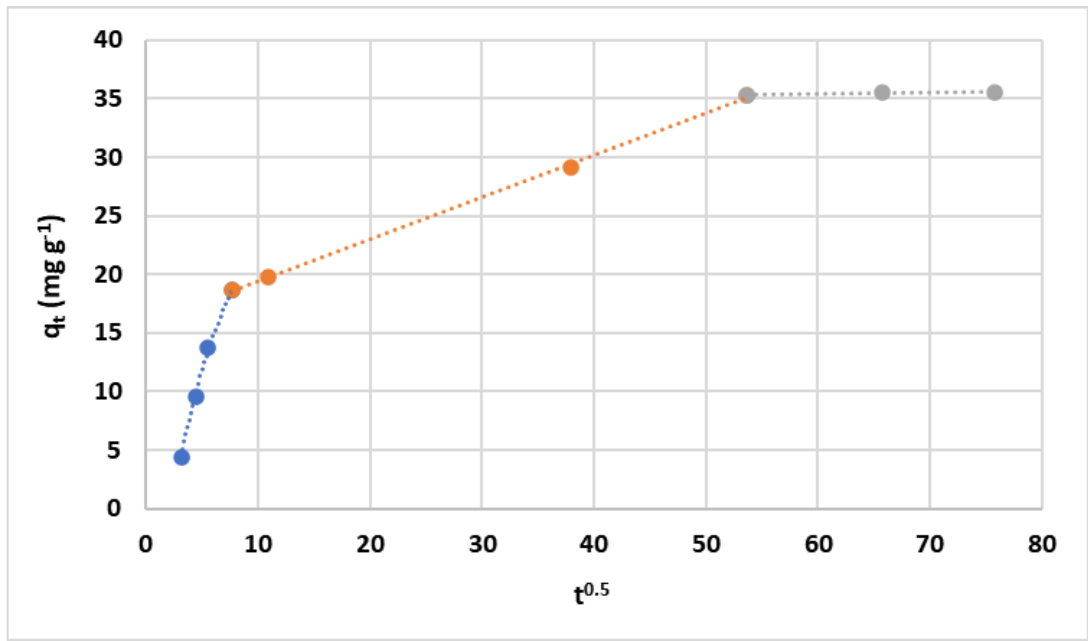
Figure 17. The model plot of Elovich for the adsorption of CR dye onto 2Clph-BU-Cs adsorbent (m = 0.01 g, C 0 = 100 mg L −1 , V = 50 mL, pH = 4, T = 298 K, and time = 48 h).